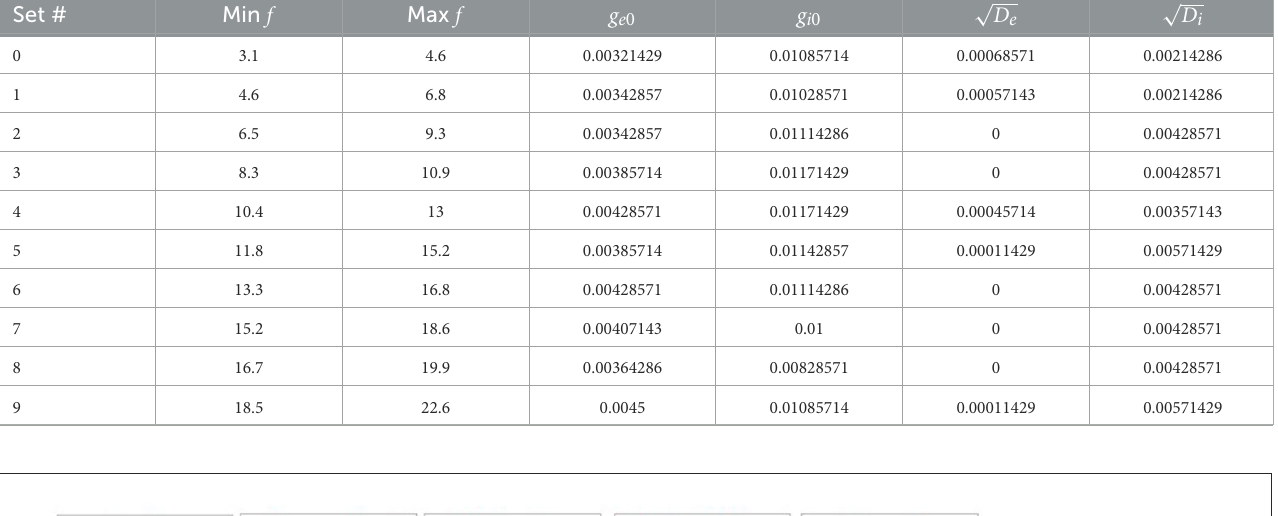
TABLE 1 Representative parameter set characteristics.